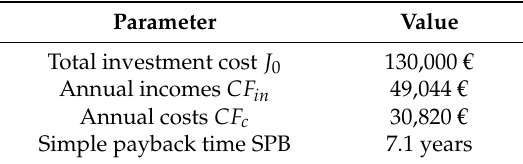
Table 4. Economic effects of heat recovery from